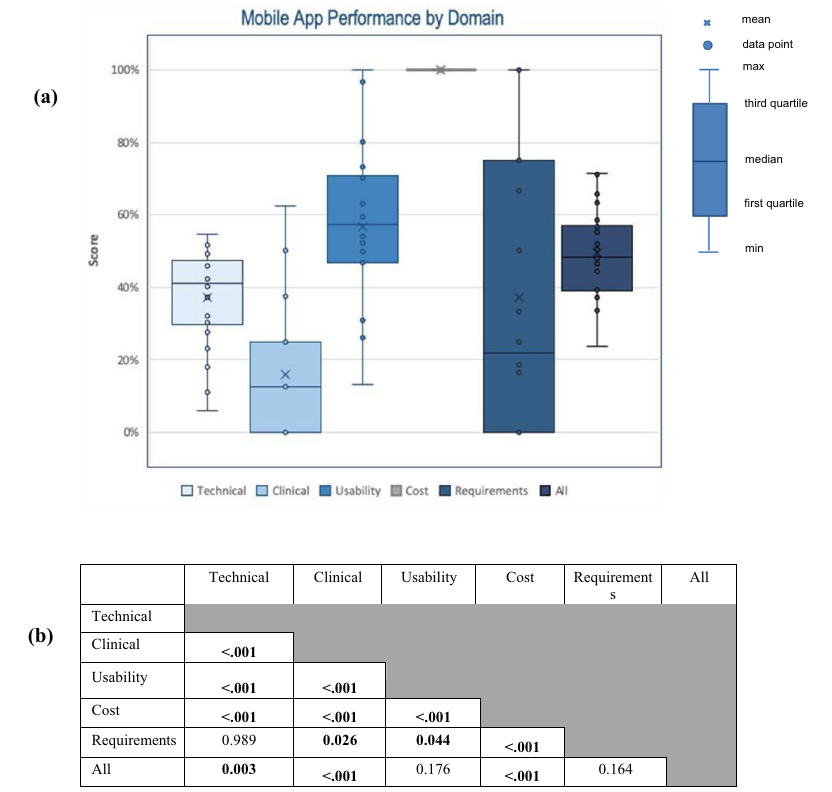
Fig. 2 Mobile app performance by domain. a Mobile app performance across domains of technical, clinical, usability, cost, and end-user requirements. b Statistical comparison of performance among domain areas and composite score with p -values